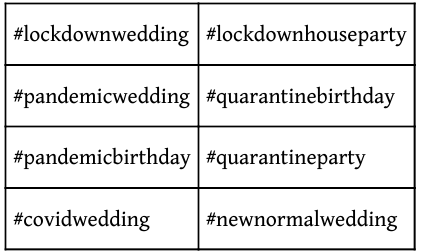
Table 8: Examples of hashtags that carry a new pandemic-related identity to the existing